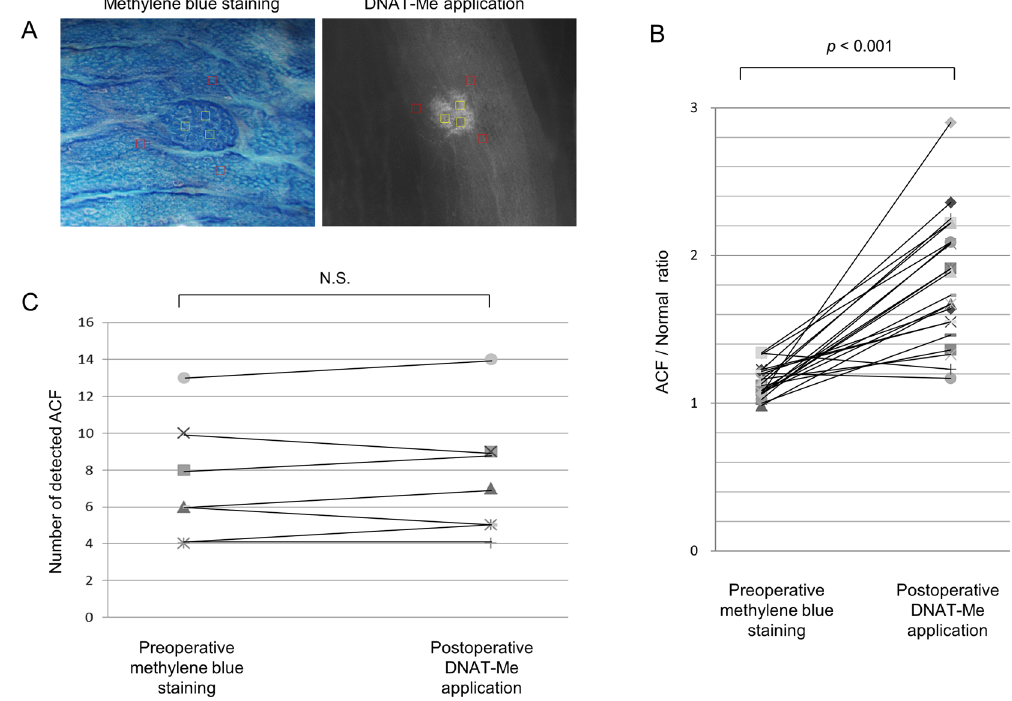
Figure 6. Comparison of signal-to-noise (S/N) ratios for ACF, and ACF counts with methylene blue staining and DNAT-Me imaging. ( A ) Representative images of an ACF obtained with methylene blue staining or DNAT-Me application. Three regions of interest (ROIs) of 250 μ m × 250 μ m (yellow squares) in the ACF and three ROIs (red squares) in the background were randomly set, and the S/N ratio calculated using image processing software. ( B ) Comparison of S/N ratios for ACF between methylene blue staining and DNAT-Me imaging. The average S/N ratios in each of the 23 ACF in pre- and postoperative examinations were plotted. ( C ) A comparison of ACF numbers as determined by methylene blue staining and DNAT-Me imaging. The number of ACFs in the 7 - cm area distal (or proximal) to the cancer was counted by preoperative methylene blue staining and by postoperative DNAT-Me application. N.S., not